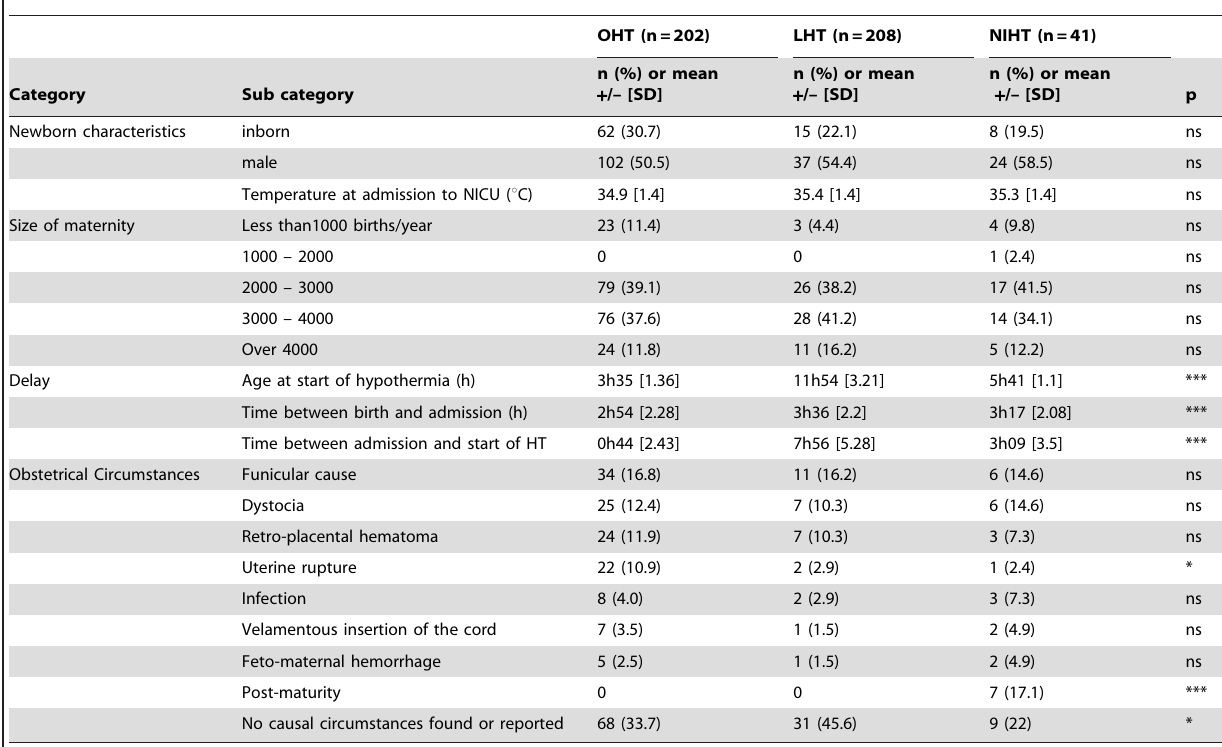
Table 3. Organization of care and birth circumstances according to HT